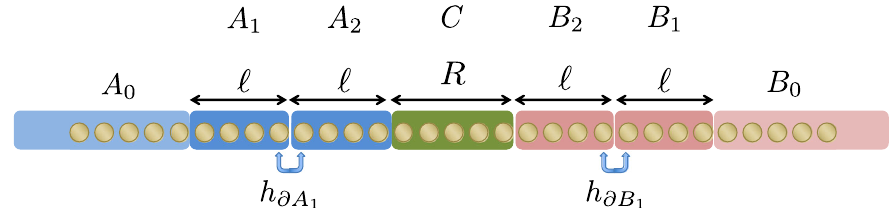
FIG. 5. For the proof, subsets A and B are decomposed into three pieces. The decomposed subsets, i.e., A 1 , A 2 , B 2 , and B 1 , are considered such that they have the same cardinality, that is, j A 1 j ¼ j A 2 j ¼ j B 2 j ¼ j B 1 j ¼ l . The interactions between the subsystems A 1 − h and A 2 ( B 1 and B 2 ) are denoted as h ∂ ( h ∂ ). Then, in the Hamiltonian H − h ∂ ∂ B 1 , the regions A 0 A 1 , A 2 CB 2 , and B 1 B 0 are A 1 B 1 A 1 decoupled. Consequently, using the quantum belief propagation, it is proven that regions A 0 and B 0 do not influence the entanglement value. Then, the entanglement between A and B is characterized by the entanglement between A 1 A 2 and B 1 B 2 . Further, because the size of these regions is 2 l , the dependence on the Hilbert space dimension in Eq. (55) is significantly